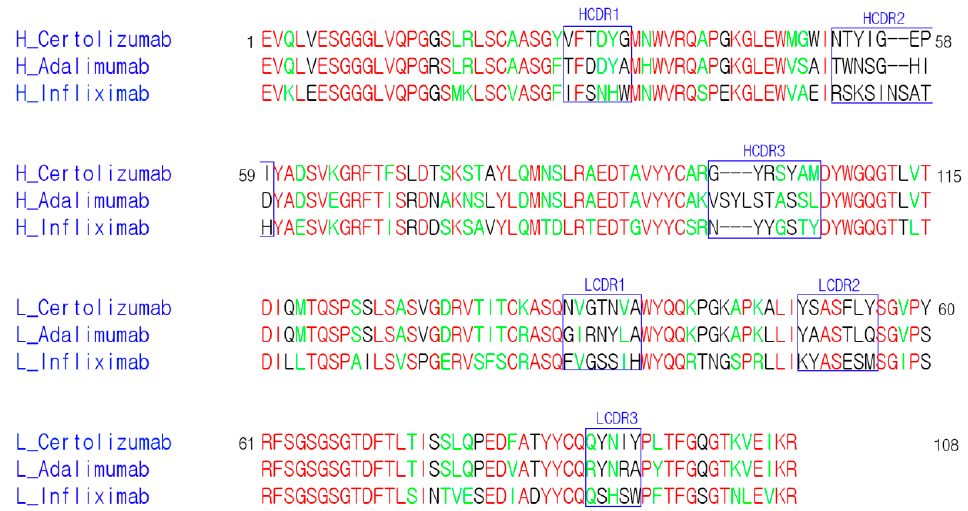
Figure 5. Sequence comparison of the antibodies against TNF α . The CDRs are indicated with boxes and labeled. The residue numbers refer to those in certolizumab. The identical and homologous residues are colored red and green, respectively.